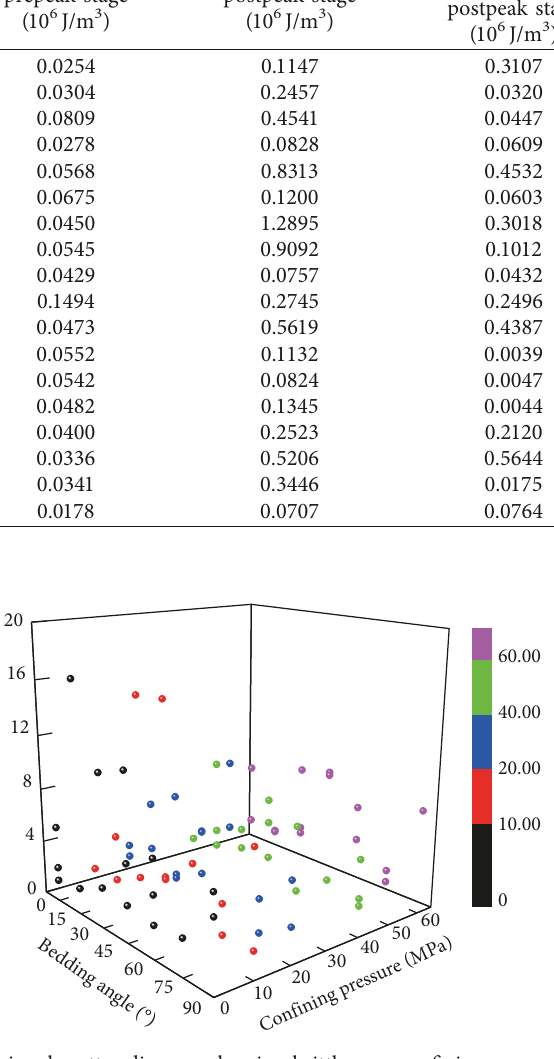
Figure 12: A three-dimensional scatter diagram showing brittleness, confining pressure, and bedding